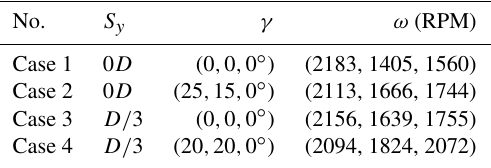
Table 1. Case configurations of the wind tunnel experiments, with the specifications of the lateral offset S y , the yaw angles γ = ( γ 1 ,γ 2 ,γ 3 ) and the rotational speeds ω = ( ω 1 ,ω 2 ,ω 3 ).